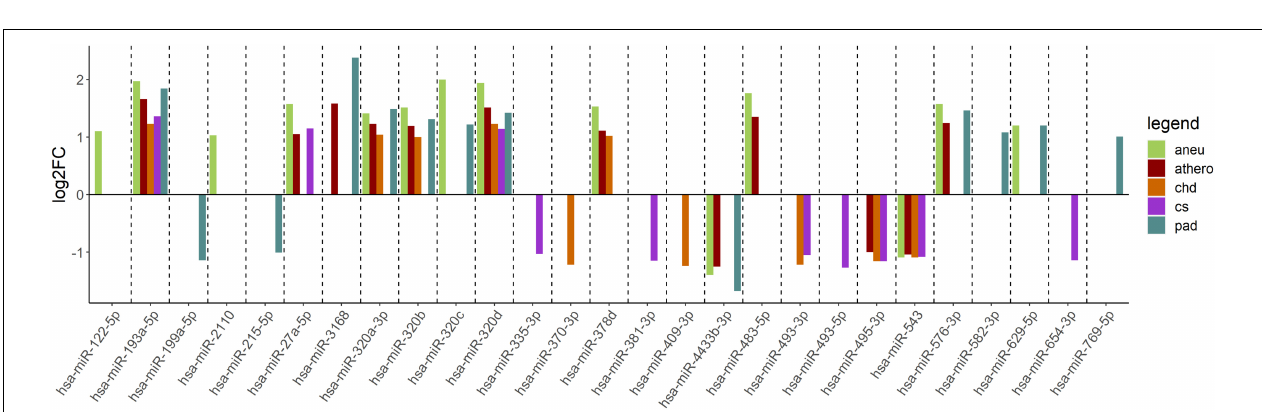
FIGURE 2 | (A) mean library size: aneu: 5.88 ± 0.53 M.; chd: 5.96 ± 0.47 M.; cs: 5.21 ± 0.49 M.; pad: 5.83 ± 0.54 M.; control: 6.7 ± 0.69; (B) mean of mapped miRNAs: aneu: 1.6 ± 0.26 M.; chd: 1.24 ± 0.17 M.; cs: 1.23 ± 0.22 M.; pad: 1.16 ± 0.18 M.; control: 1.43 ± 0.17; (C) mean relative frequency of mapped read counts. aneu = abdominal aneurysm; chd = coronary heart disease; cs = carotid stenosis; pad = peripheral artery disease; control = control group; No Adapter = reads without adapter; Short = reads smaller than 16 nt; Unmapped = reads which are not mapped to reference; rRNA = reads mapped as rRNA; snRNA = reads mapped as snRNA; snoRNA = reads mapped as snoRNA; tRNA = reads mapped as tRNA; miRNA = reads mapped as miRNA.